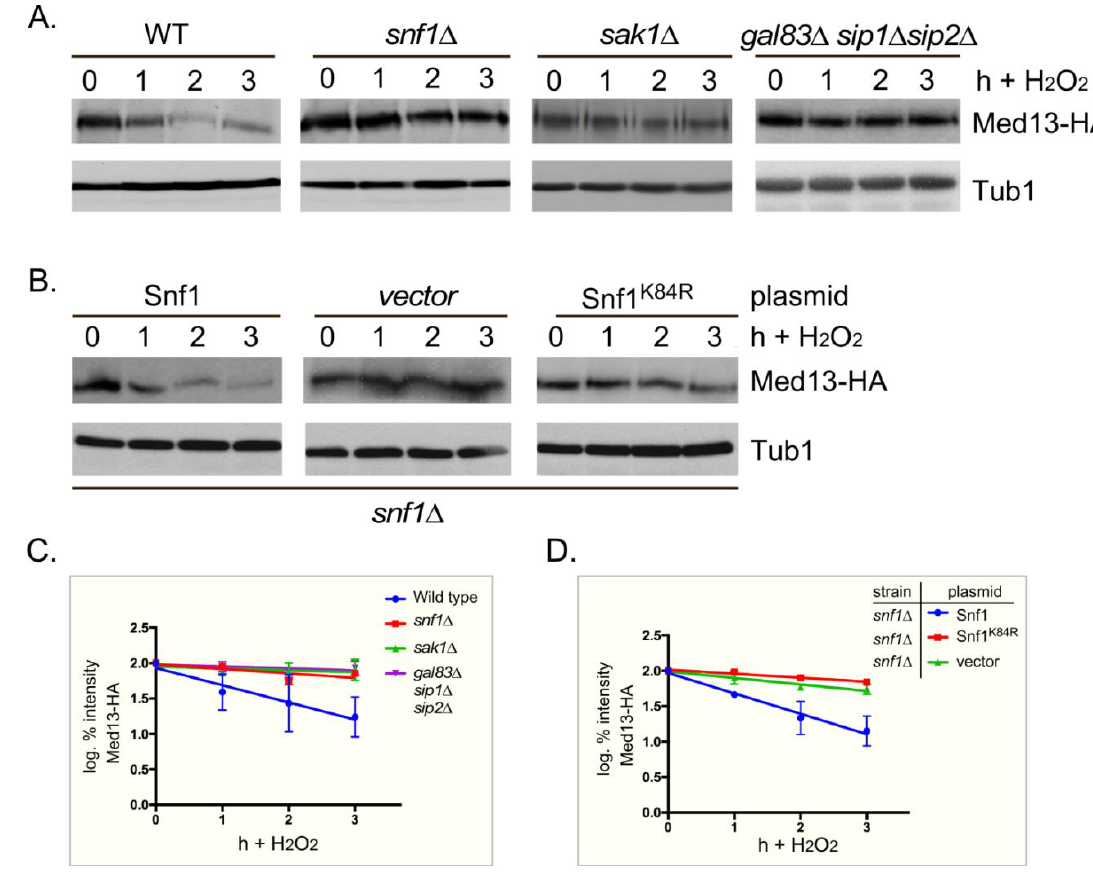
FIGURE 3: Snf1, Sak1 and at least one β subunit are required for degradation of Med13 following H 2 O 2 stress. (A) Wild-type (RSY10), snf1 ∆ (RSY2080), sak1 ∆ (YPDahl17) and gal83 ∆ sip1 ∆ sip2 ∆ (MSY557) cells harboring full length Med13-HA (pKC801) were treated with 0.4 mM H 2 O 2 for the timepoints indicated and Med13-HA levels analyzed by Western blot. Tub1 levels were used as a loading control. (B) snf1 ∆ cells harboring Med13-HA (pKC803) and either wild- type Snf1 (JG1193), a vector control (pRS316) or snf1 K84R (JG1338) were treat- ed and analyzed as described in A. (C and D) Degradation kinetics of the Med13-HA shown in A and B. Values represent averages ± SD from a total of at least two Western blots from independent